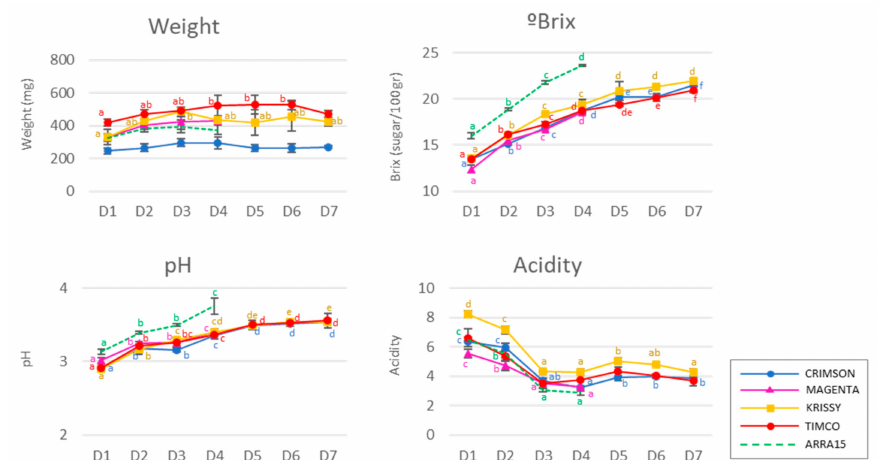
Figure 1. Berry general analyses: weight, ◦ Brix, pH, and acidity. Di ff erent superscript letter indicates statistically significant di ff erences among the sampling times D1–D7 ( p < 0.05). Sampling along harvest: